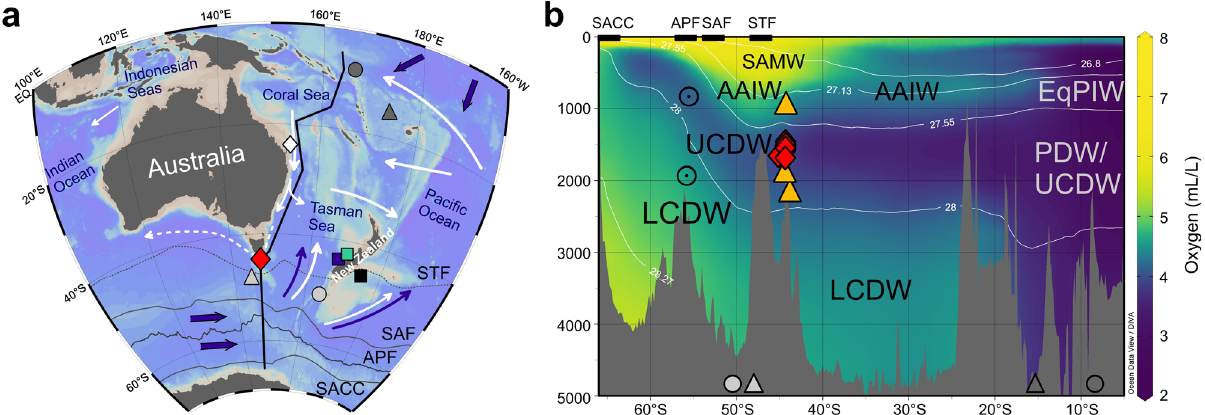
Fig. 1 Coral sample locations and regional hydrography. a Map showing the coral sample locations south of Tasmania (red diamond) and locations of seawater Nd isotope pro fi les from stations SR3-60 (light gray triangle), TAN0803-41 (light gray circle), GeoB17019-1 (dark gray triangle), and GeoB17018- 1 (dark gray circle) 38,40 . Solid white arrows indicate simpli fi ed fl ow paths of intermediate waters, while the dashed arrow indicates the Tasman Leakage, and dark blue arrows represent deep water fl ow 11,13,76,94 . The mean positions of the Subtropical Front (STF), Subantarctic Front (SAF), Antarctic Polar Front (APF), and Southern ACC front (SACC) are indicated by gray lines 14 . Colored squares indicate locations of important paleoceanographic records from sediment cores MD06-2986 (dark blue, 1477 m water depth), SO136-003GC (green, 944 m water depth) 66 , and MD97-2120 (black, 1210 m water depth) 65 . The white diamond indicates the location of core FR1/97 GC-12 (990 m water depth) 85 . b Oxygen concentration section 95 (along the black line in a ), highlighting the major subsurface water masses in the study area: Subantarctic Mode Water (SAMW), Antarctic Intermediate Water (AAIW), Upper Circumpolar Deep Water (UCDW), Lower Circumpolar Deep Water (LCDW), Paci fi c Deep Water (PDW), and Equatorial Paci fi c Intermediate Water (EqPIW) representing a mixture of AAIW originating from the Southeast Paci fi c and upwelled PDW 13,38 . Thin black lines indicate surfaces of neutral density anomalies γ n (in kg/m 3 ) 96 . Yellow triangles and red diamonds depict sampling depths of modern and fossil corals, respectively. Ocean fronts and locations of water column pro fi les (gray circles and triangles) as in a . Base map in a and oxygen section in b generated with ODV software 97